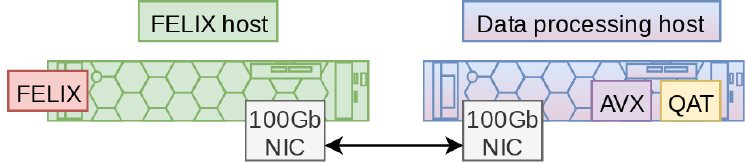
Figure 3. The publish-subscribe FELIX solution, initially applied in ProtoDUNE-SP’s TPC readout.